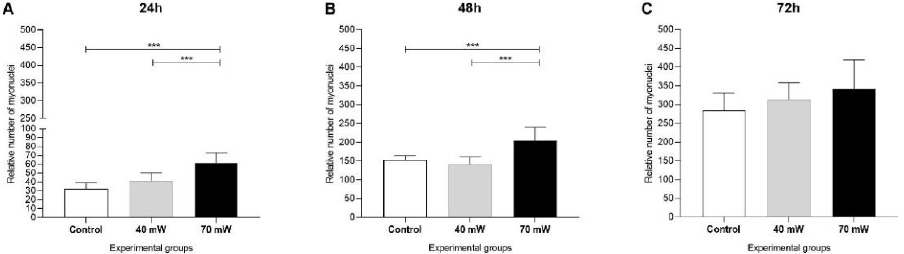
Figure 3. Proliferation of C2C12 myoblasts submitted to LED after ( A ) 24 h, ( B ) 48 h, and ( C ) 72 h (ANOVA/Tukey); *** p < 0.001.